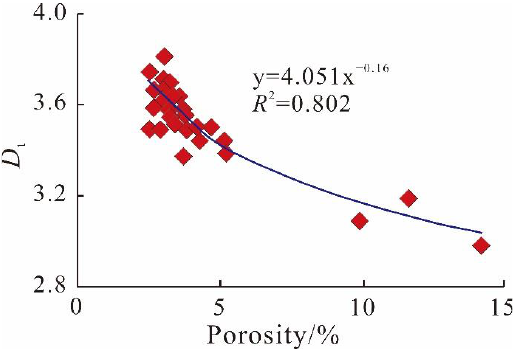
Figure 12. Relationship between porosity and comprehensive fractal dimension ( D t ).